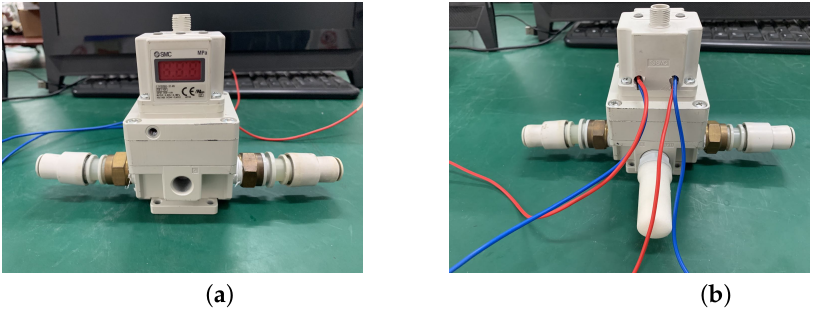
Figure 7. The proportional valve after the transformation. ( a ) The front part of the valve; ( b ) the rear part of the